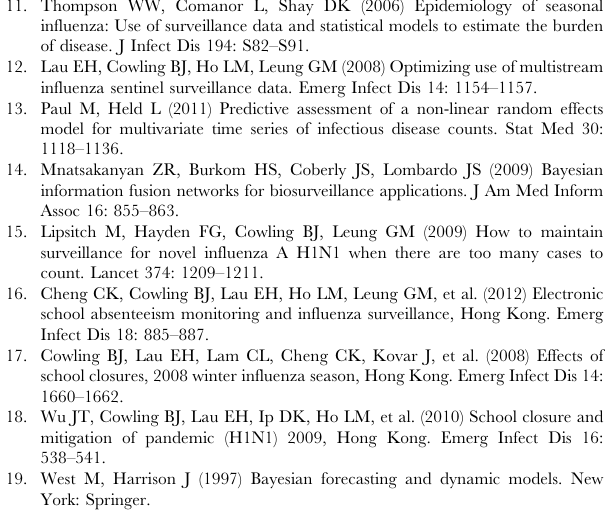
Table S1 Test of differences in correlations with influenza activity, between surveillance data and inferred influenza level